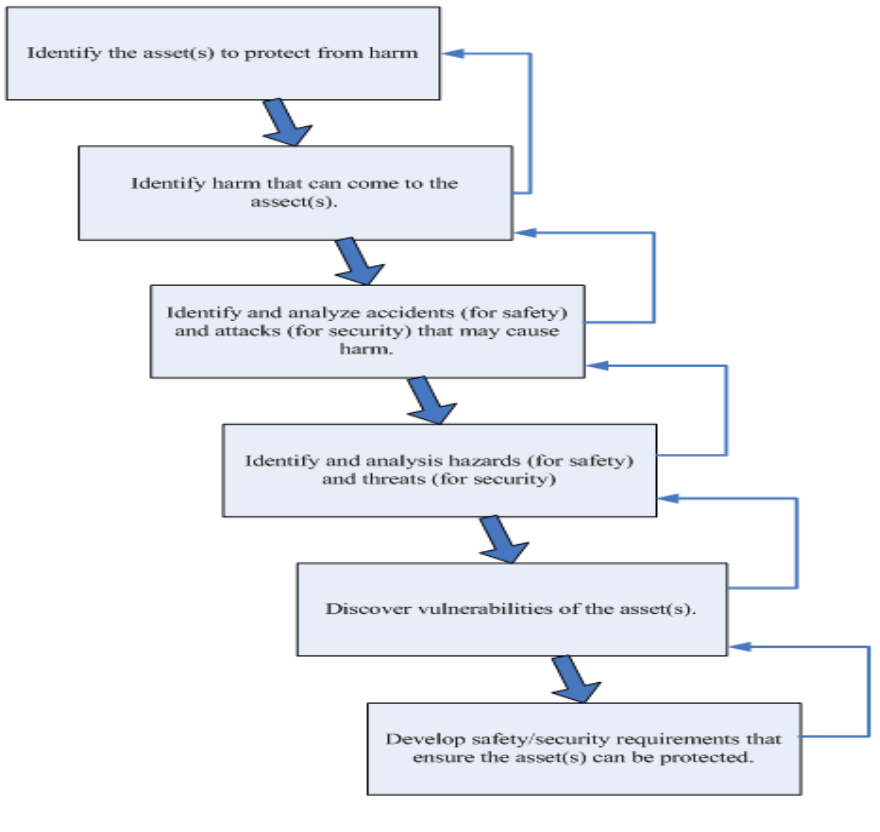
Figure 1. Safety/security engineering